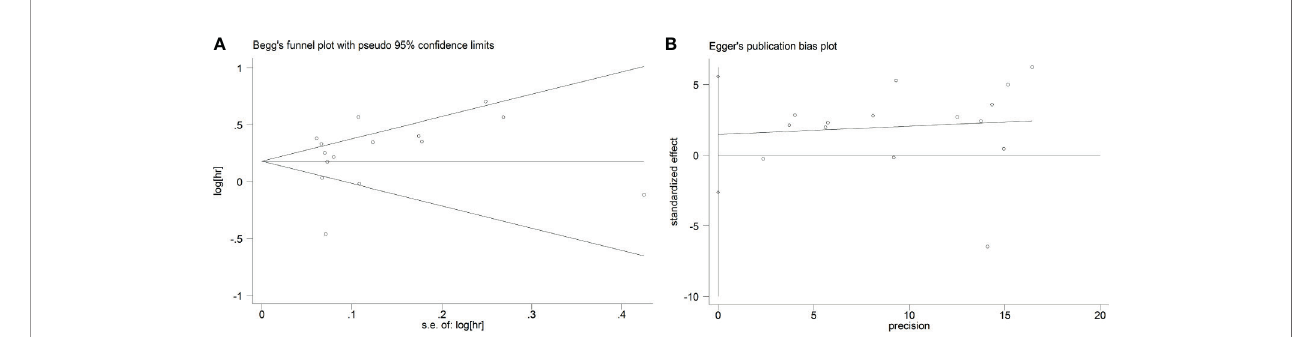
FIGURE 7 | Begg ’ s (A) and Egger ’ s (B) tests to detect publication bias in studies of HBV